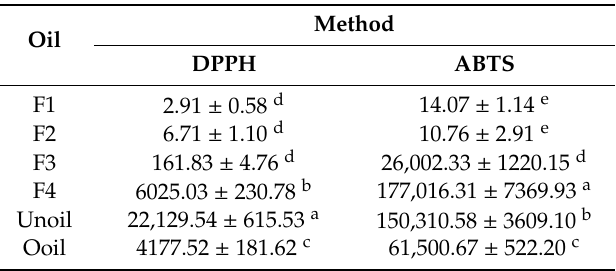
Table 3. Antioxidant activity ( µ mol TE / g evaluated oil).